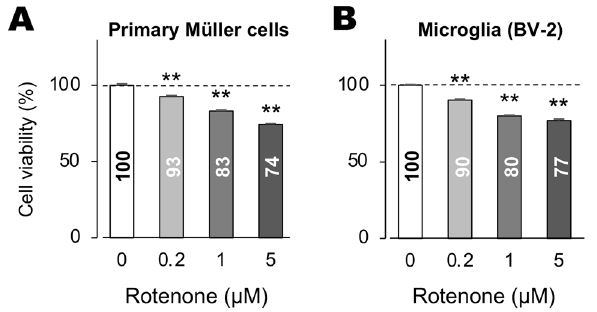
Figure 1. Viability of rotenone-treated Müller and BV-2 cells. ( A , B ) AlamarBlue cell viability assay of mouse primary Müller cells ( A ) and mouse brain-derived microglia BV-2 cells ( B ). Cell viability decreased in a dose- dependent manner for rotenone. Error bars indicate standard deviation. ** P < 0.01 versus rotenone (−) controls (Dunnett’s test; n =